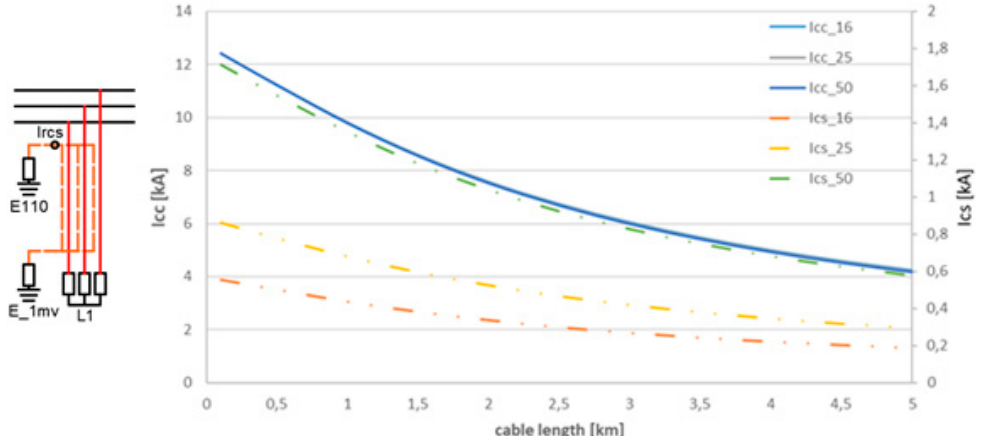
Figure 13. Current induced in cable screens under 2f fault conditions at the end of cable line ( I cc —cable core current; I cs —cable screen current). Configurations are marked with the color red—energized cable—and orange—cable screen.